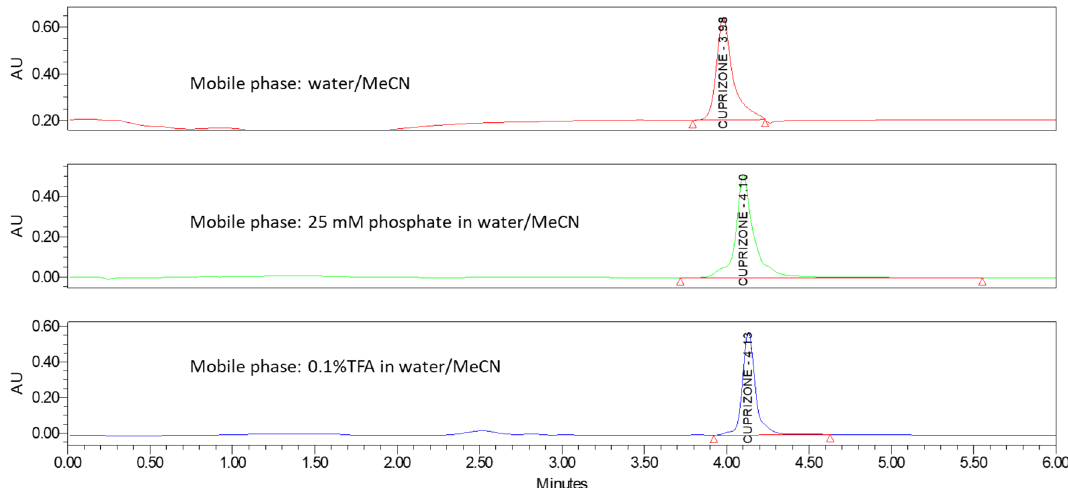
Figure 6. HPLC chromatogram of Cuprizone in Xbridge HILIC column with different mobile phases (from top to bottom): water/ MeCN; 25 mM phosphate in water/ MeCN and 0.1%TFA in water/ MeCN.